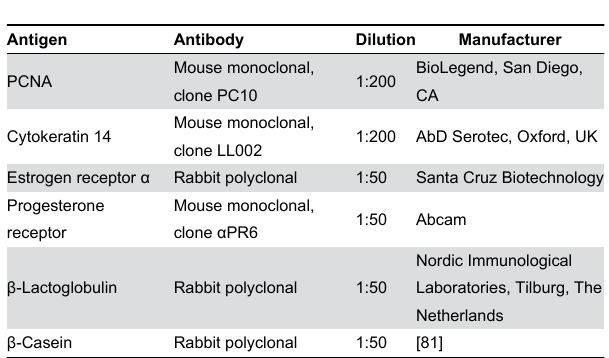
Table 1. List of primary antibodies applied in the immunoblot